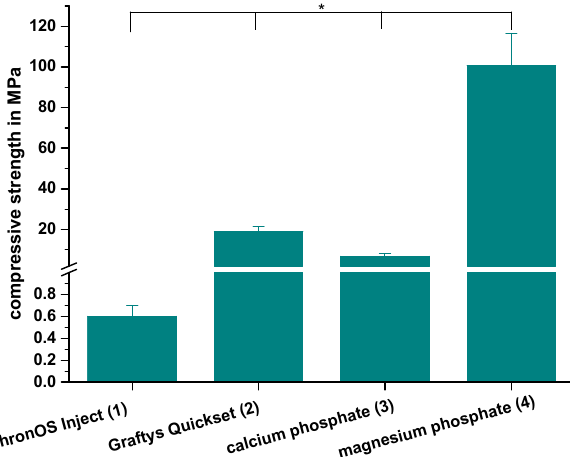
Figure 7. Compressive strength. Significant highest compressive strength for the MPC: Compressive strength of cuboidal samples from commercial ChronOS TM Inject (group 1), Graftys ® Quickset (group 2) and in-house-prepared dual setting calcium phosphate (group 3) and magnesium phosphate (group 4) after 24 h of setting in water at 37 ◦ C. All di ff erences between the single groups were significant (groups 1,2; groups 1,3; groups 1,4; groups 2,3; groups 2,4; groups 3,4). Significant di ff erences (*) were set at p < 0.01